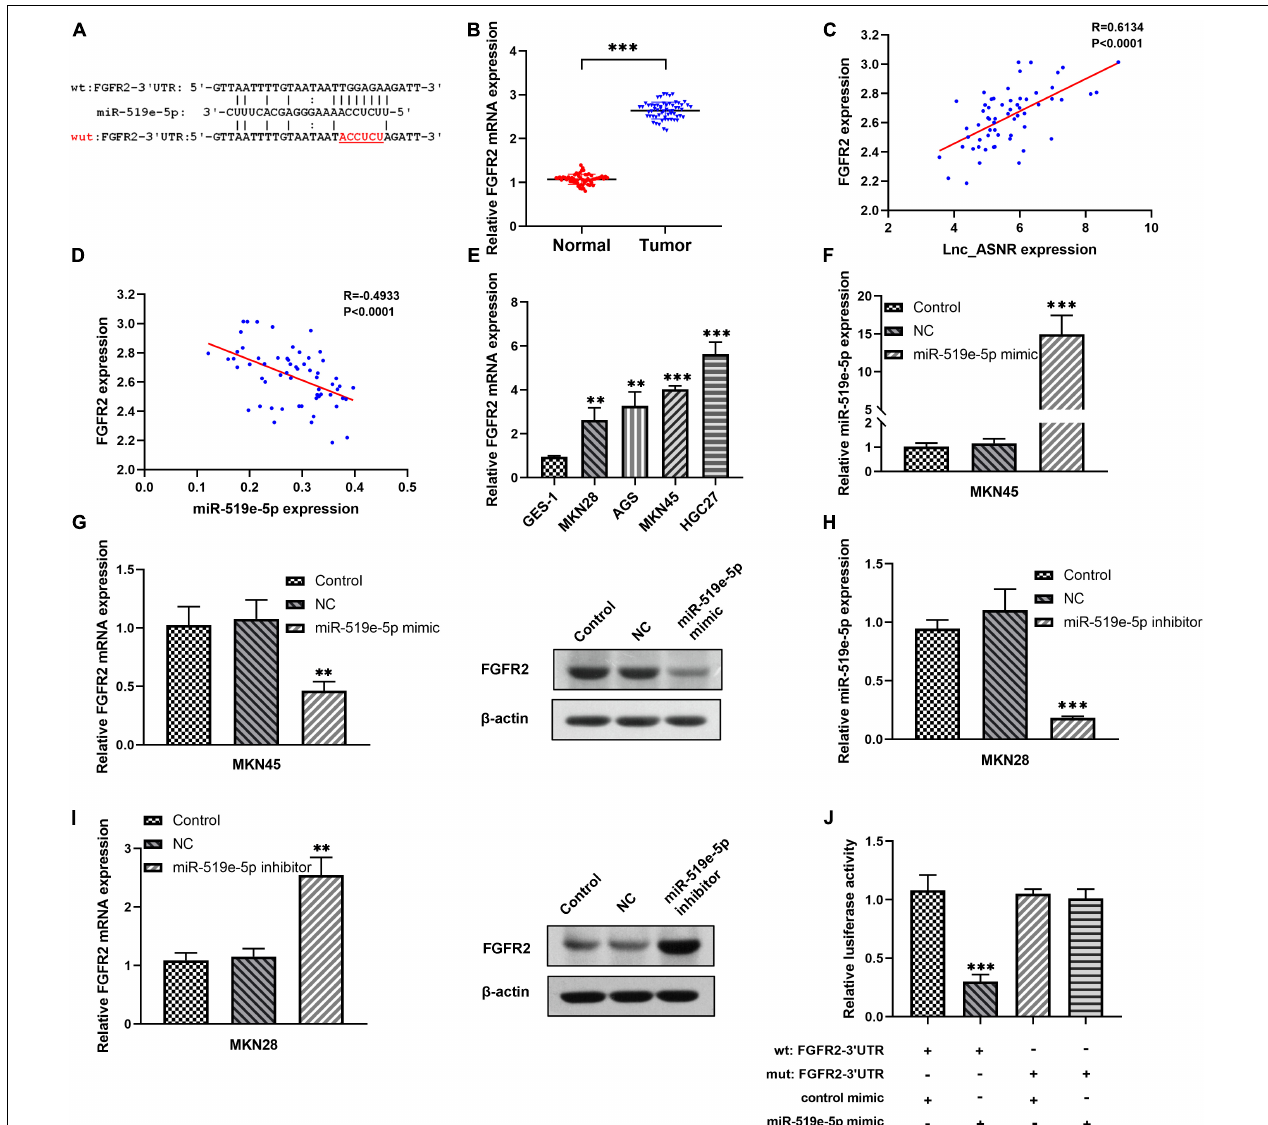
FIGURE 6 | The relationship between FGFR2 and miR-519e-5p in GC cells. (A) The potential binding sites between miR-519e-5p and FGFR2 were predicted from “Targetscan” website (http://www.targetscan.org/) and “miRDB” website (http://mirdb.org/). (B) qRT-PCR was applied to indicate the expression of FGFR2 in GC tissue samples and adjacent non-tumor tissue samples. (C) Correlation analysis was used to evaluate the relationship between FGFR2 expression and Lnc_ASNR expression. (D) Correlation analysis was used to evaluate the relationship between FGFR2 expression and miR-519e-5p expression. (E) qRT-PCR showed the expression of FGFR2 in the normal cell line and GC cell lines. (F) qPCR detected the overexpress efficiency of miR-519e-5p mimic. (G) Relative FGFR2 expression and protein levels in GC cells after miR-519e-5p was overexpressed. (H) qPCR detected the silence efficiency of miR-519e-5p inhibitor. (I) Relative FGFR2 expression and protein levels in GC cells after miR-519e-5p was silence. (J) Luciferase activity examination. Error bars, mean ± SEM. * P < 0.05; ** P < 0.01; *** P <